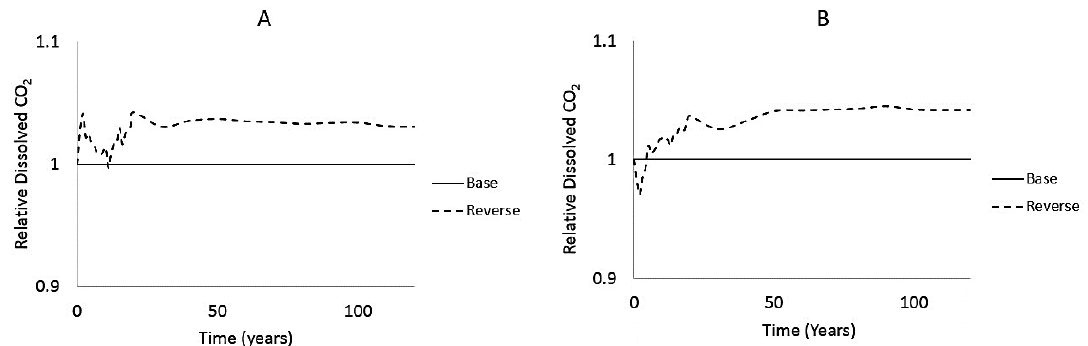
Figure 9. Effect of two layers of permeability heterogeneity on the dissolution of CO 2 in brine in two cases. ( A ) First simulation with the first set of heterogeneity data, ( B ) Second simulation with the second set of heterogeneity data.